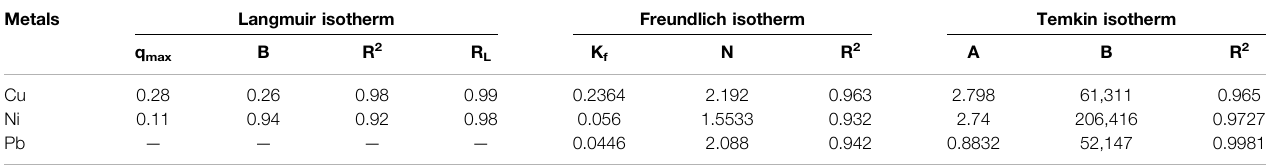
TABLE 2 | Adsorption of Cu, Ni, and Pb on the PANI-WH composite by Langmuir, Freundlich, and Temkin isotherms.